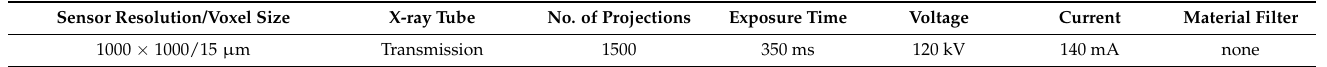
Figure 5. The element’s fixture in consecutive measurement systems: ( a ) X-ray CT, ( b ) focus variation microscope, ( c ) structured blue-light scanner. Table 1. Measurement set-up for X-ray computed